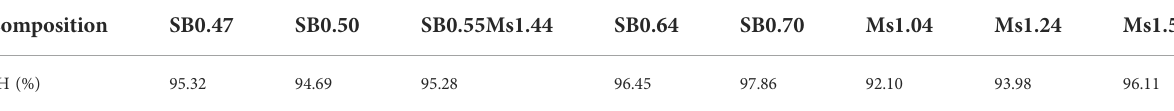
TABLE 6 RH values of the solution of each composition.